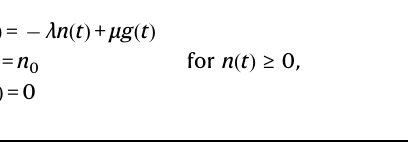
Fig. 1 | Standard representationofthe role ofnucleases in lytic infections. A In the absence of infection, the bacterial cell is free from viral DNA and may display basal levels of restriction nucleases capable of cleaving non-self DNA. B In case of infection, the host detects the presence of phage DNA and triggers an innate immune response that includes the upregulation of restriction nucleases. C The balance between the replication of the viral DNA and its destruction by bacterial nucleasesdeterminesthe eventualoutcomeofthe infection. D If thephage evades